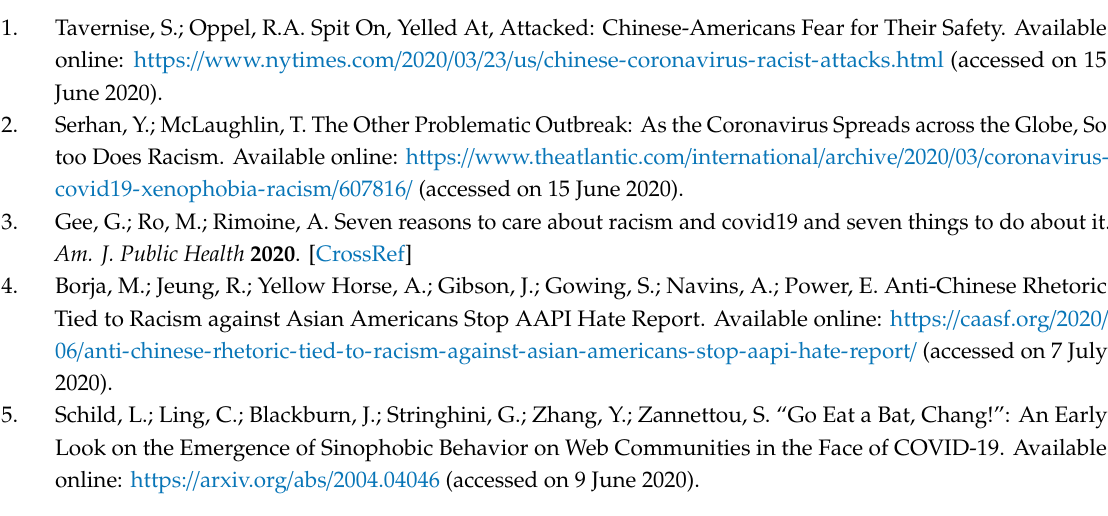
Figure S1: Temporal changes in negative Black sentiment, November 2019–April 2020, Figure S2: Temporal changes in negative Latinx sentiment, November 2019–April 2020, Figure S3: Temporal changes in negative Asian sentiment by state, Figure S4: Temporal changes in positive Asian sentiment by state, Figure S5: Temporal trends in Google Searches of “wuhan virus” and “china virus”, Table S1: Percent negative tweets using Asian and Chinese-related keywords by month, November 2019–June